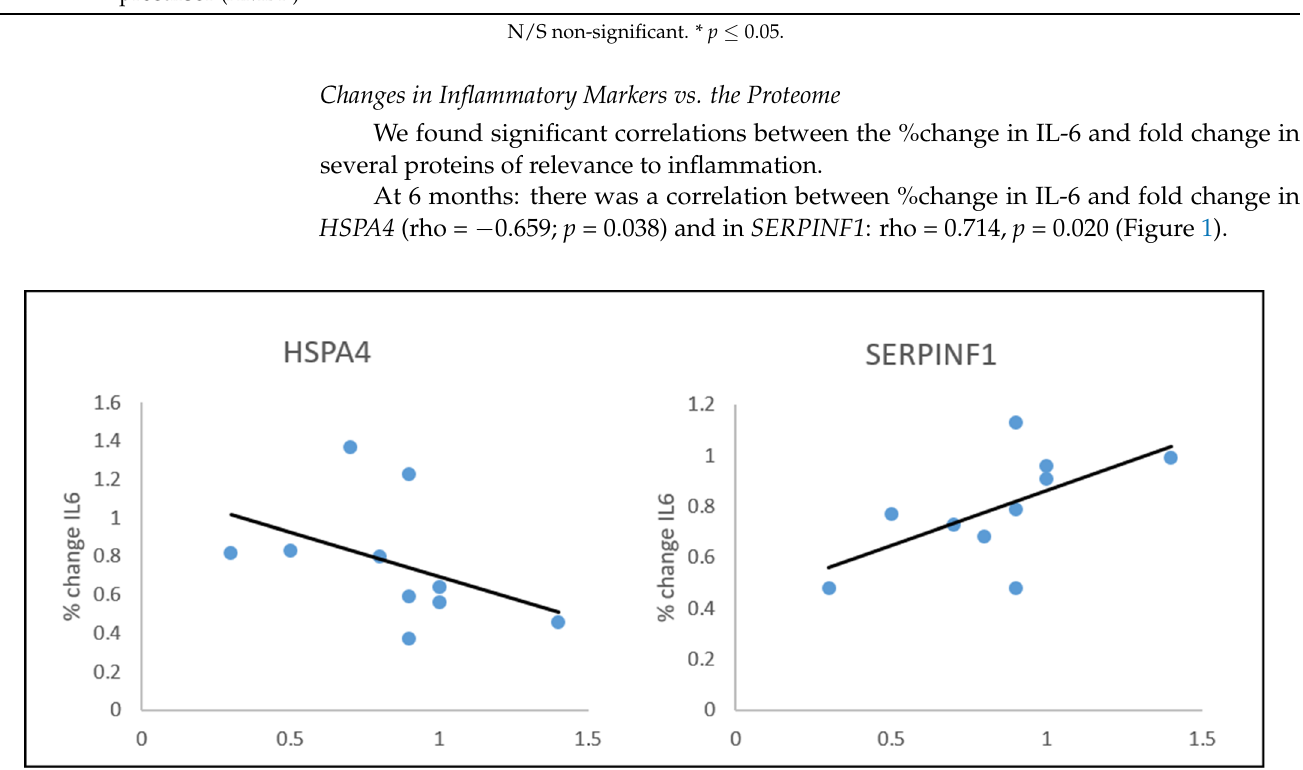
Figure 1. Spearman’s correlations between IL6 % change and plasma proteins at 6 months post-bariatric surgery. At 12 months: there was a positive correlation between %change in IL-6 and the fold change in the following proteins— LGALS3BP : rho = 0.700, p = 0.036; HSP90B1 : rho = 0.667, p = 0.05; ACE : rho = 0.667, p = 0.05 (Figure 2A).